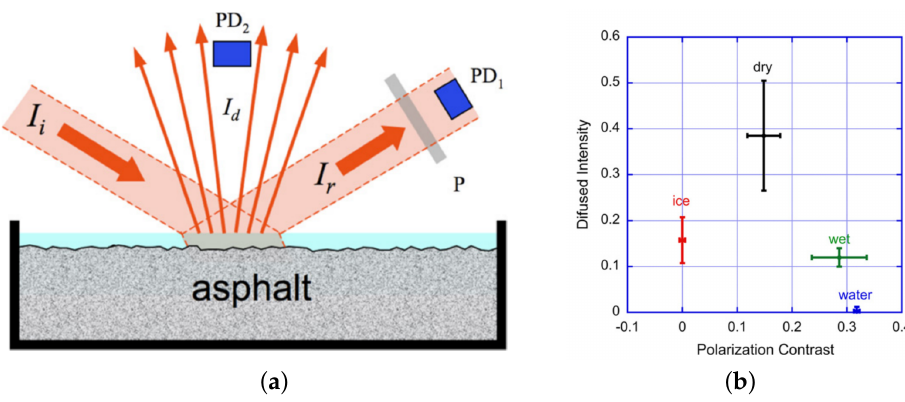
Figure 13. ( a ) Schematic of the Colace polarisation experiment. ( b ) Comparison of diffuse reflectance intensity and polarisation